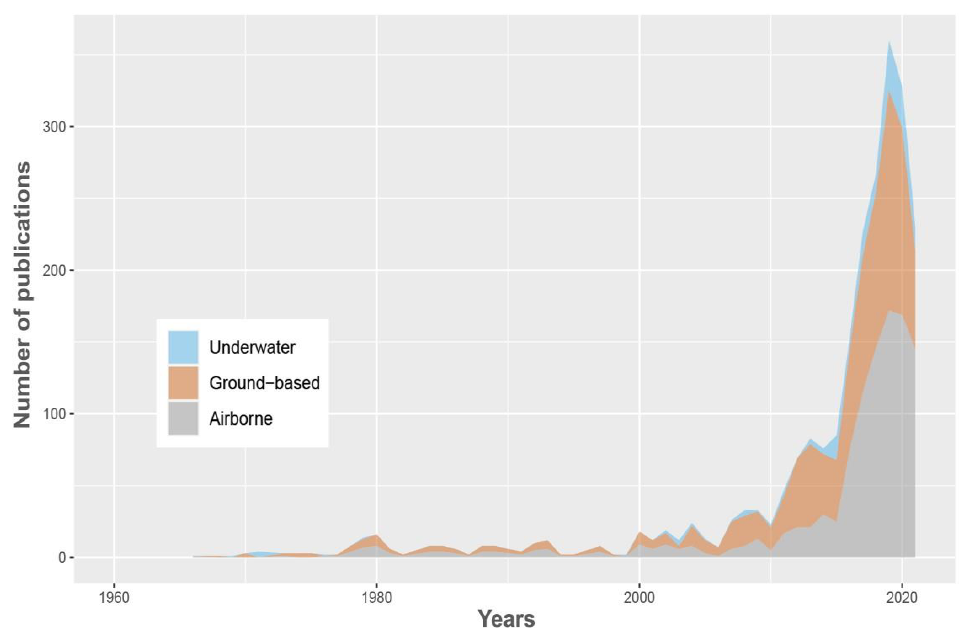
Figure 2. Area plot representing the number of publications per year in the function of the type of photogrammetry applied.